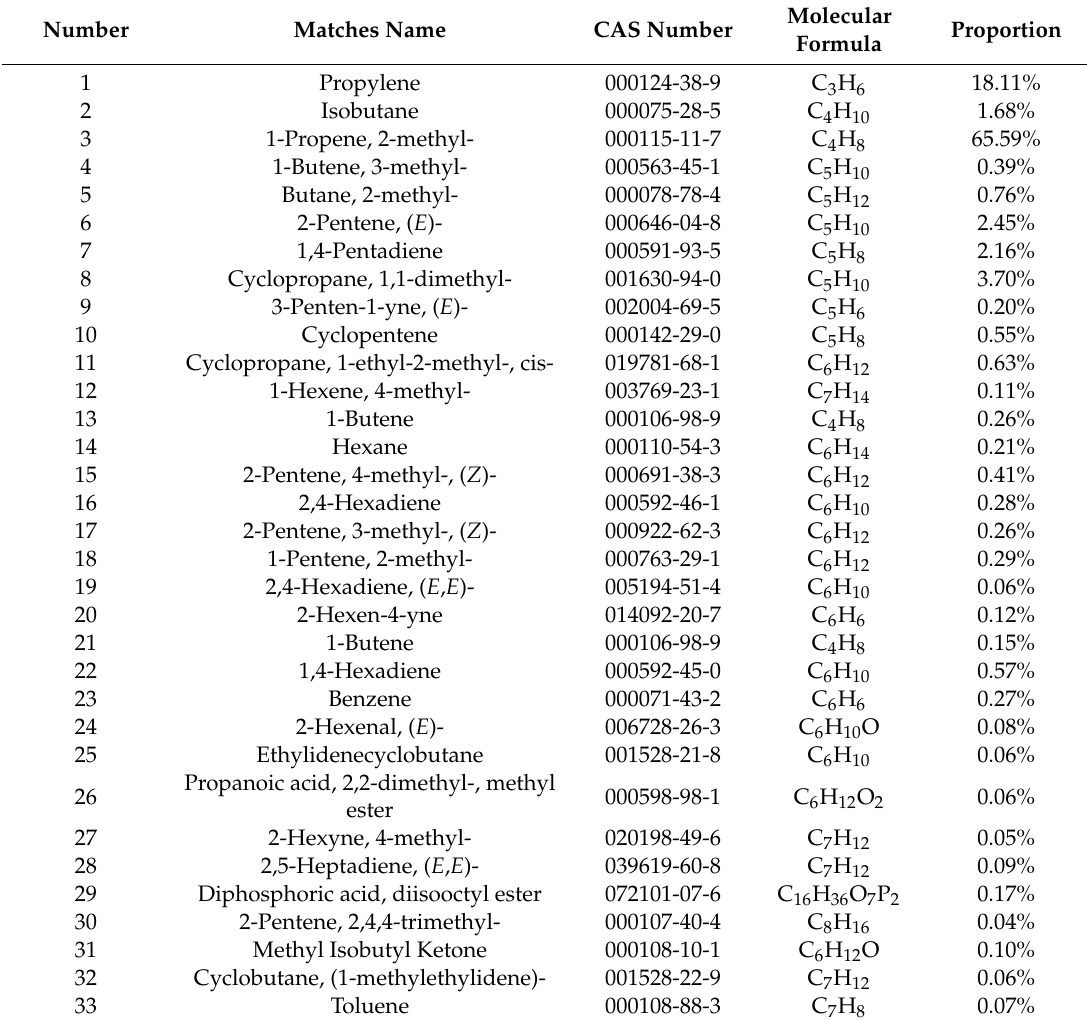
Table 7. Pyrolysis gas components and content in Experiment